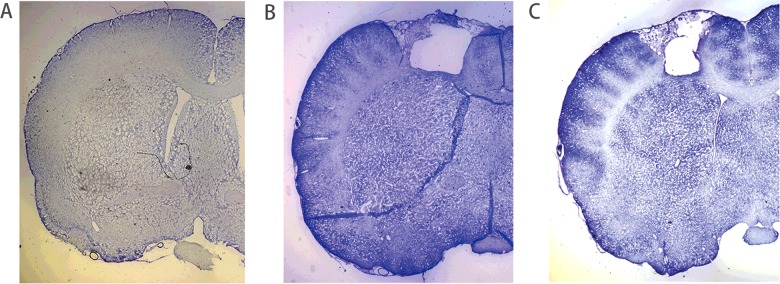
Histological changes of the left motor cortex in three groupsPhotothrombotic cortical lesion in the left hindlimb motor cortex (Nissl stain, magnification ×25). (A) Nissl-stained coronal section from group A. (B and C) Nissl-stained coronal sections from groups B and C, the left motor cortex showed specific lesion.